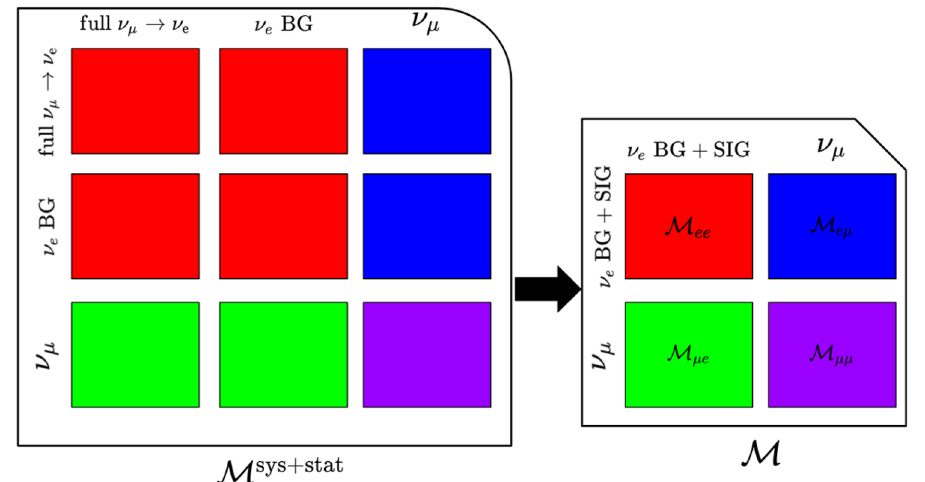
Figure 10 . Color scheme to collapse the matrix M sys+stat (left) into the matrix M (right) by overlapping blocks with the same color. Observe that the (cid:12)nal matrix M is divided in the sub- blocks M ee , M (cid:22)(cid:22) , M e(cid:22) and M (cid:22)e , which will be useful in the performance of electron neutrino appearance